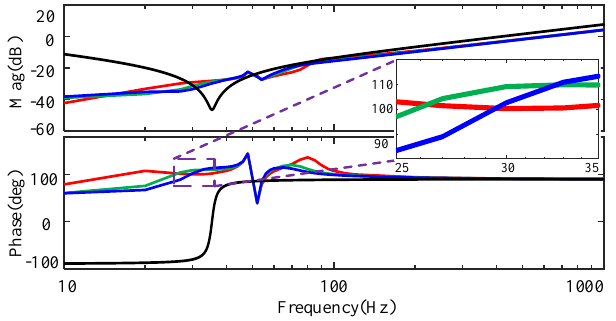
Figure 13. Bode diagram of different inertia of reactive power. Red line: 0.5 J Q 0 ; green line: J Q 0 ; blue line: 1.5 J Q 0 .